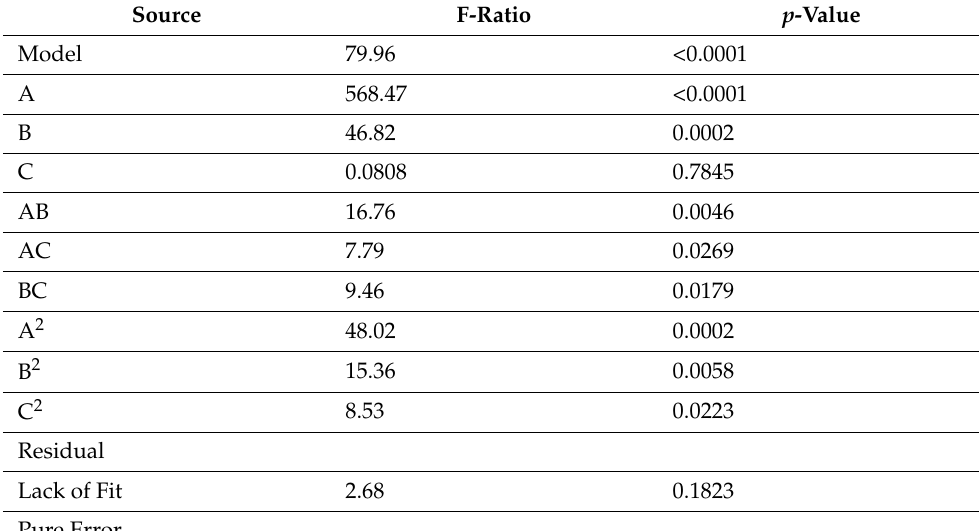
Table 4. Analysis of variance data for droplet